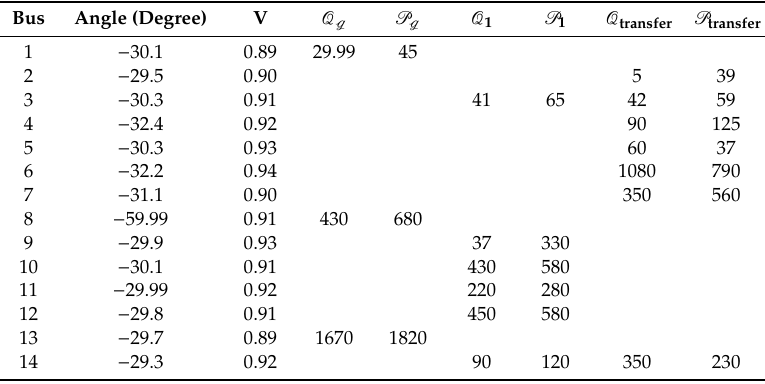
Table 8. Result of loads at maximum